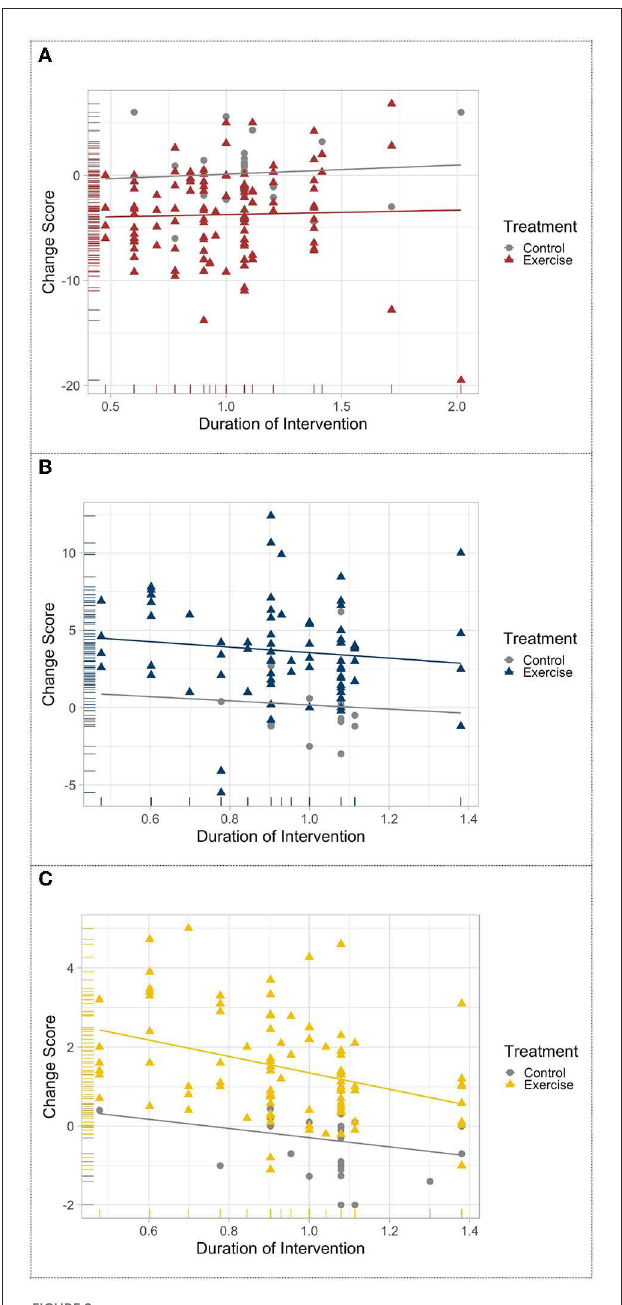
FIGURE2 Meta-regression of the change in (A) UPDRS-motor scale, (B) balance, and (C) mobility after exercise treatment across time.